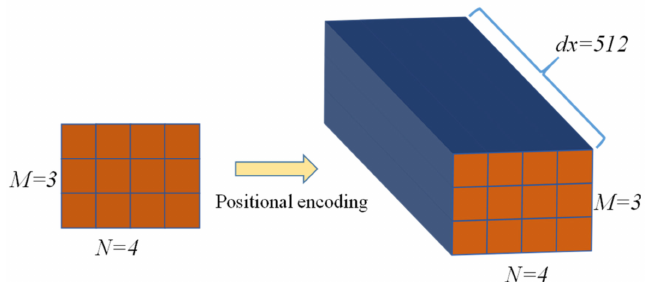
Figure 5. Process of dimensionality increase for positional